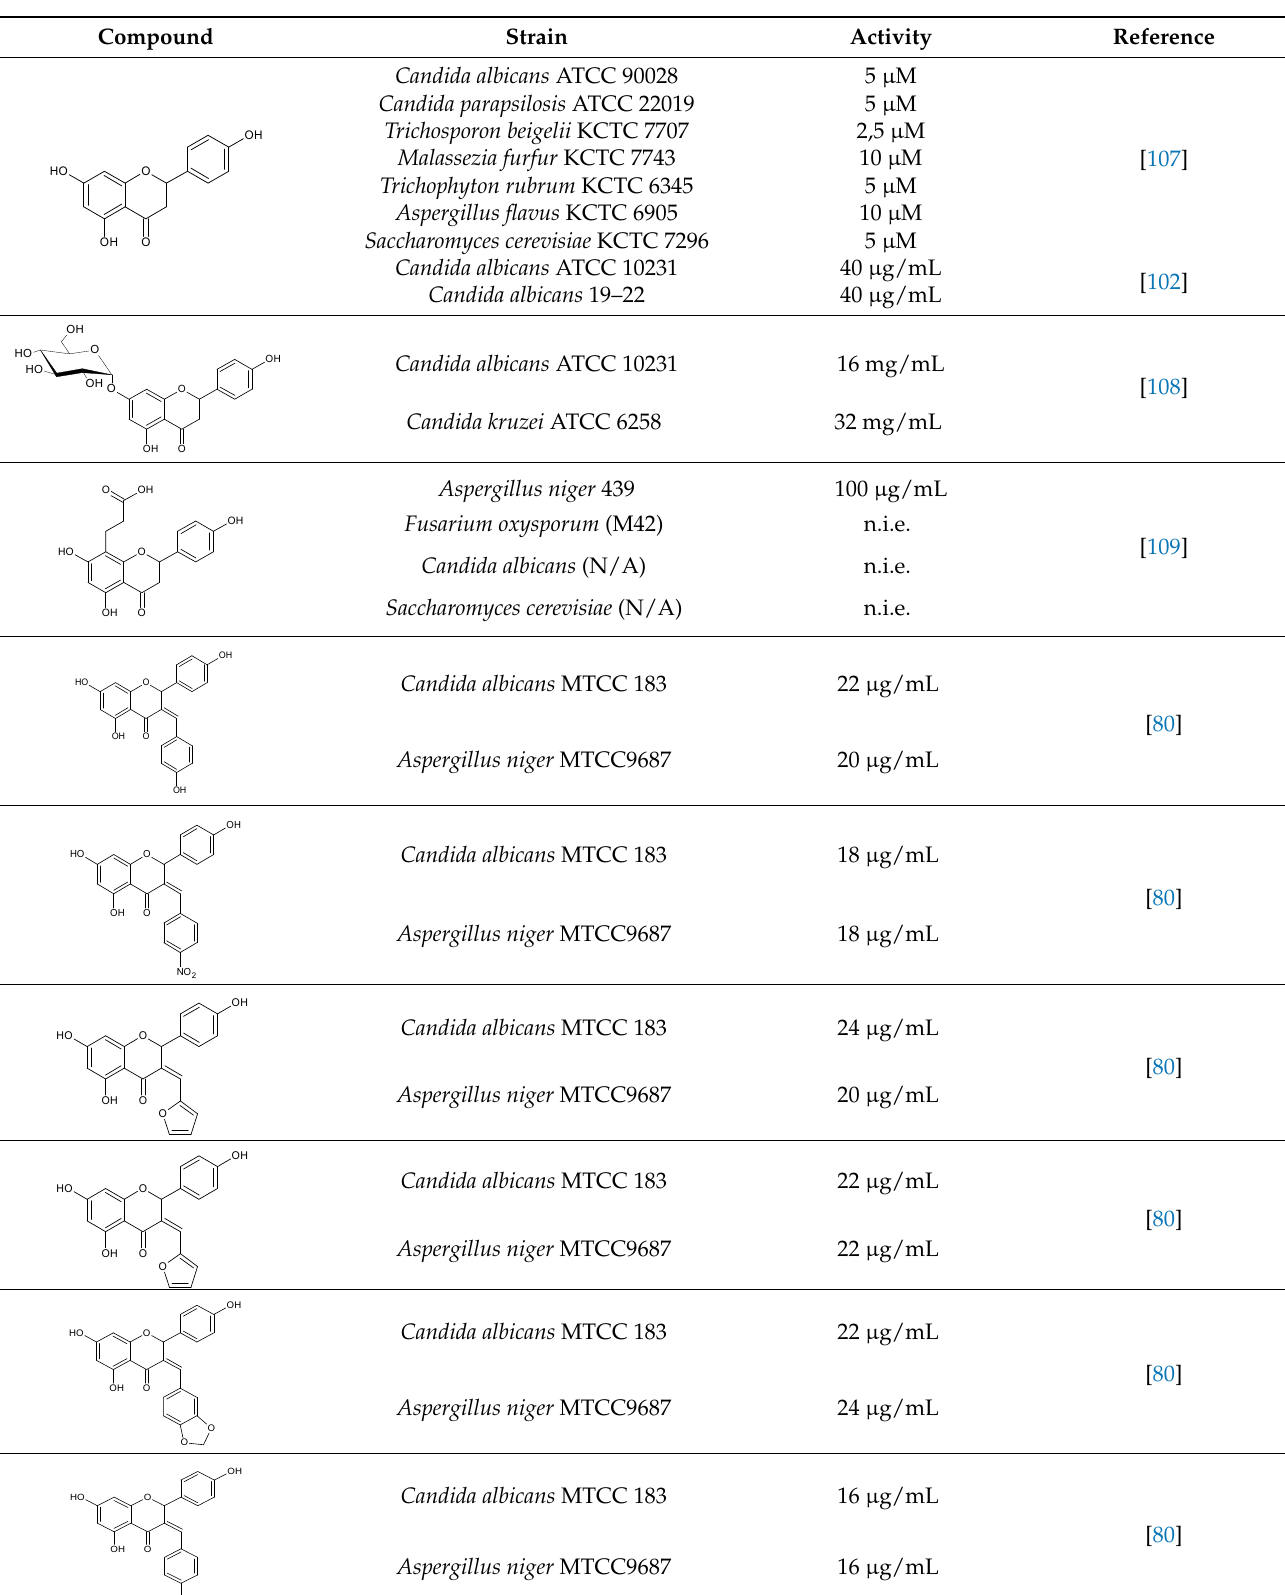
Table 2. In vitro activity of naringenin and its derivatives against selected fungi strains. Compound Strain Activity Reference